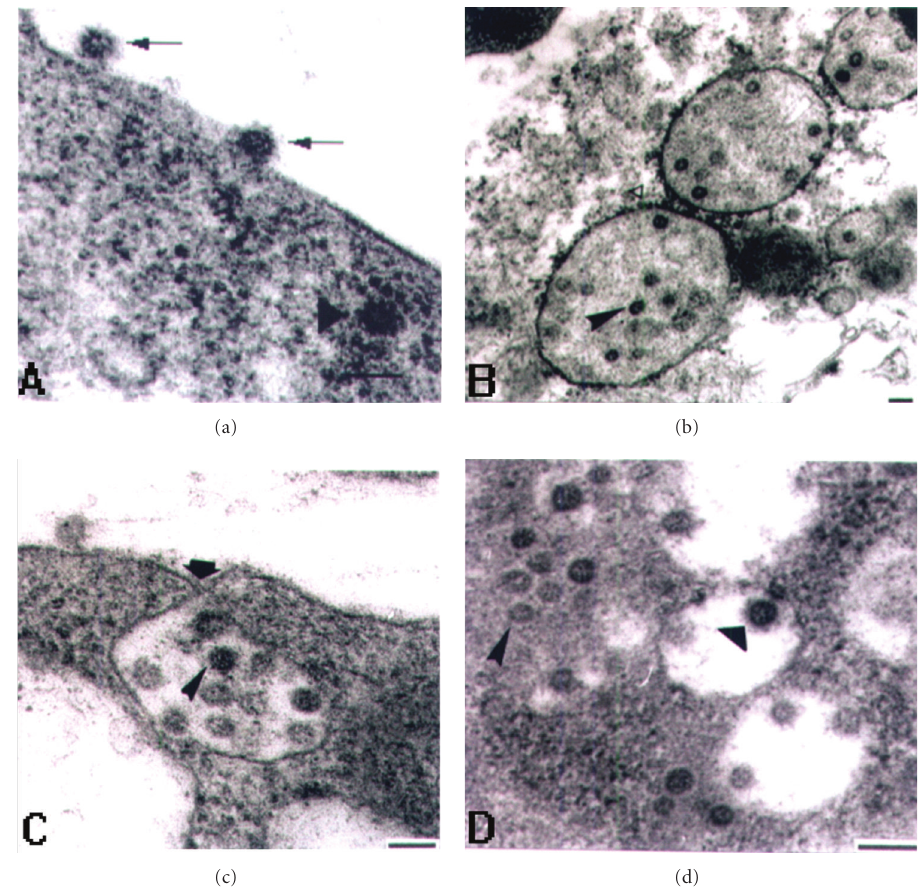
Figure 2: Severe acute respiratory syndrome-associated coronavirus (SARS CoV) in Vero E6 cell. (a) The virions attached themselves to the cell surface (arrow), and then their envelopes fused with cell membrane and the nucleocapsids entered the cell. The contours of these nucleocapsids were blurry after the virions lost their envelopes (arrowhead). (b) Nucleocapsids assembled in the swollen RER (arrow). Some ribosomes attached on the membrane of the RER. (c) Release of the virions from the cell. A smooth vesicle was fusing with the cell membrane (wide arrow); virions still located in the smooth vesicles (sharp arrow). (d) Budding of the nucleocapsids from the VMMV to the smooth vesicles. The SARS CoV nucleocapsids budded from the VMMV (sharp arrow) into the smooth vesicles and obtained spikes and envelopes (wide arrow). Bar = 100nm